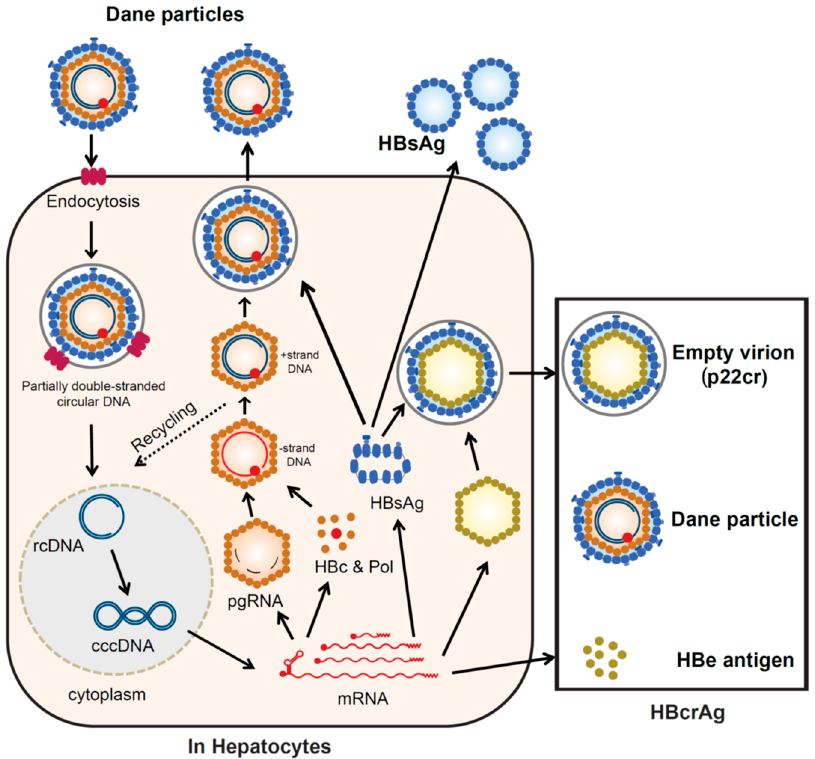
Figure 2. HBV replication cycle. The schematic depicts the steps involved in the HBV replication cycle. It shows the sources of various HBV-related molecules used routinely for diagnosis, clinical monitoring, and prognosis of HBV